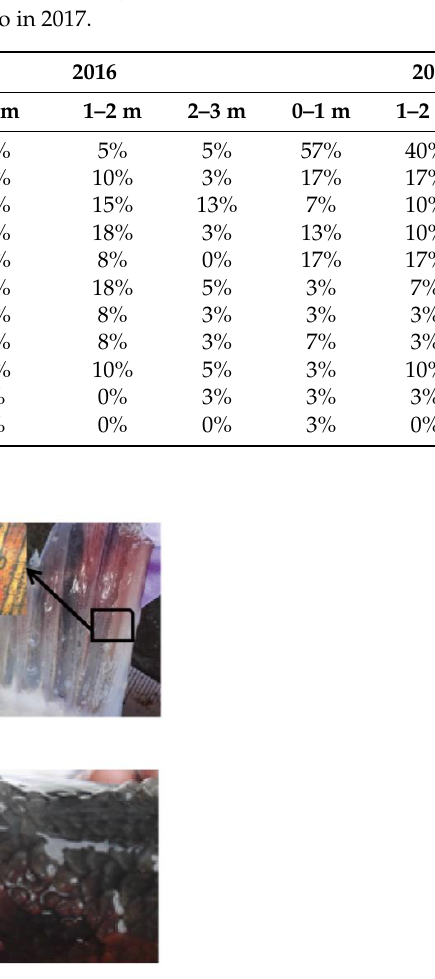
Figure 2. Typical symptoms of GBD; bubbles were observed in ( a ) the pectoral fin, ( b ) the anal fin, and ( c ) the dorsal fin, while ( d ) shows corneal emphysema. Table 1. Prevalence of S. prenanti with different GBD symptoms during the TDG supersaturation exposure experiments in 2016 and 2017; 40 adult S. prenanti were used in each scenario in 2016 while 30 adult fish were used in each scenario in 2017.